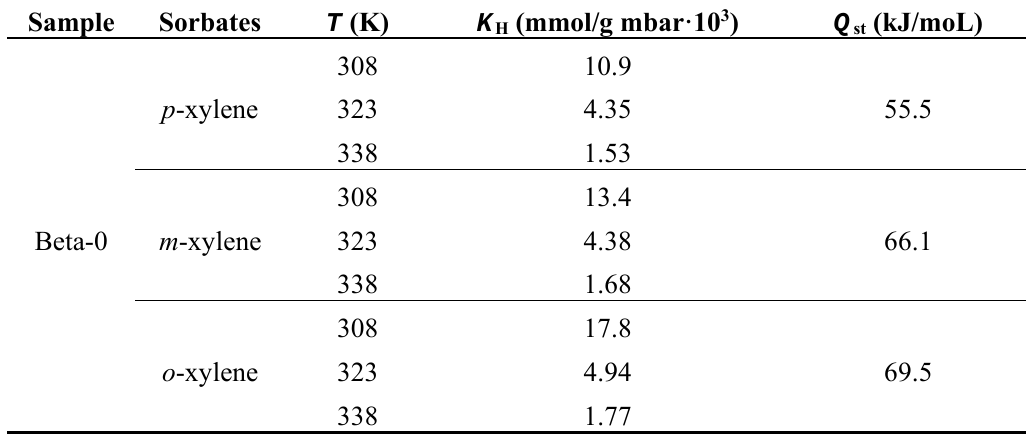
Table 4. Henry’s constants ( K H ) and heats of adsorption at zero coverage ( Q st ) for xylene isomers on Beta zeolite